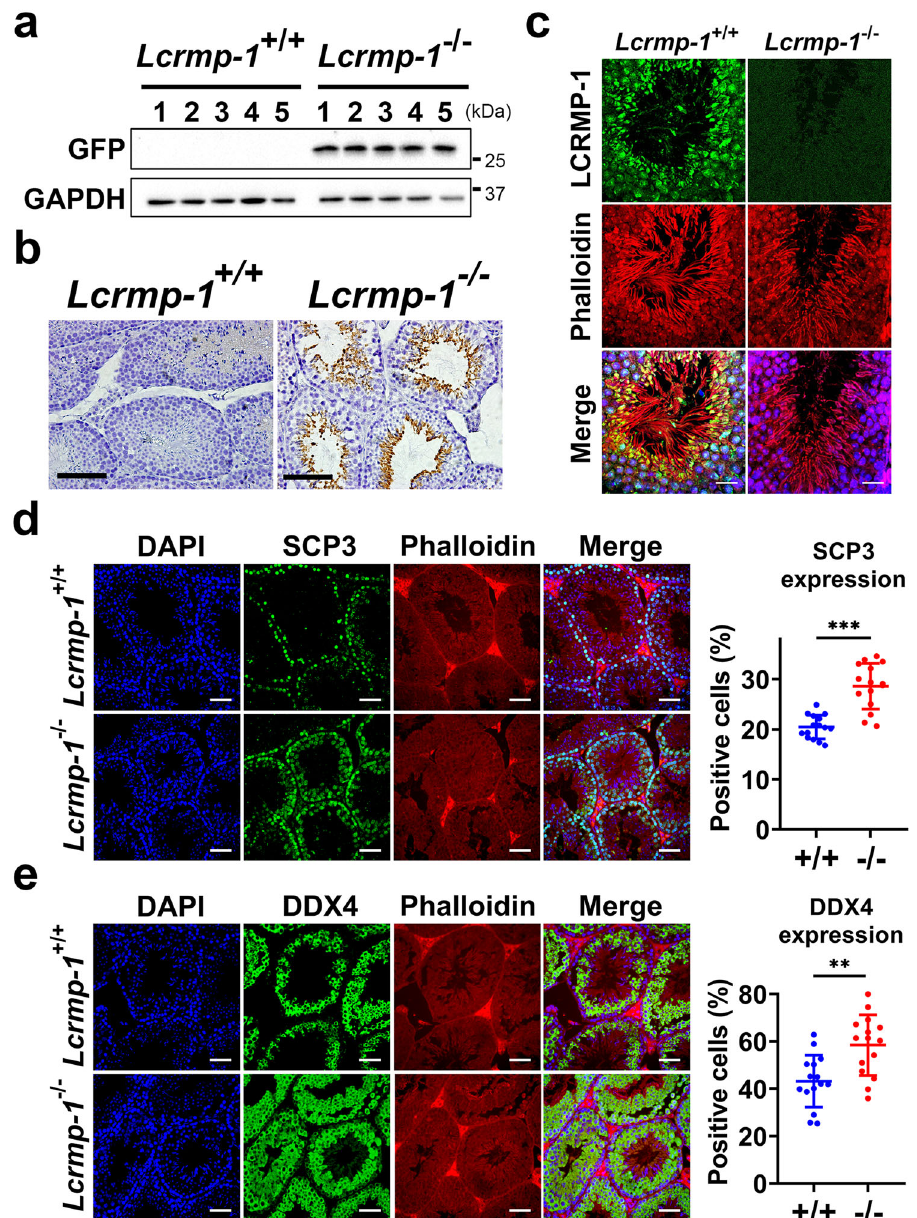
Fig. 3 LCRMP-1 which is highly expressed near the lumen of seminiferous tubules affects immature germ cells. a LCRMP-1 expression in the testes, as represented by eGFP, in a Western blotting analysis of Lcrmp-1 + / + and Lcrmp-1 − / − mice. The presence of the eGFP signal con fi rms that the Lcrmp-1 gene locus had been replaced by the eGFP gene. b Immunohistochemical staining for LCRMP-1 expression patterns in the seminiferous tubules, as indicated by eGFP signaling. LCRMP-1 was highly expressed in the late spermatogenesis. Scale bars, 100 μ m. c Immuno fl uorescence staining for LCRMP-1 localization in the seminiferous tubules using LCRMP-1 speci fi c antibody (green), phalloidin-iFluor (red), and DAPI (blue) followed by confocal microscopy analysis. Scale bars, 20 μ m. d SCP3 immuno fl uorescence staining of the testes of Lcrmp-1 − / − and Lcrmp-1 + / + mice. SCP3-positive cells were signi fi cantly more abundant in Lcrmp-1 − / − than in Lcrmp-1 + / + mice. The fl uorescence signal was measured using ImageJ software and the ratio was calculated as the total number of Alexa Fluor 488 Dye (green) cells divided by the total number of DAPI (blue) cells (triplicate, Lcrmp-1 + / + , n = 5; Lcrmp-1 − / − , n = 5; mean ± SD, two-tailed Student ’ s t -test, *** p < 0.001). Scale bars, 50 μ m. e DDX4 immuno fl uorescence staining of the testes of Lcrmp-1 − / − and Lcrmp-1 + / + mice. DDX4-positive cells were obviously more abundant in Lcrmp-1 − / − than in Lcrmp-1 + / + mice. The fl uorescence signal was measured using ImageJ software followed by